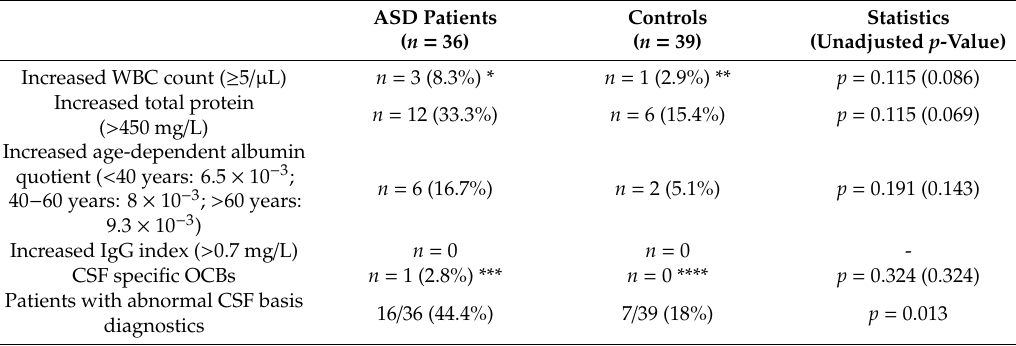
Table 4. Number of subjects with abnormal CSF diagnostics.